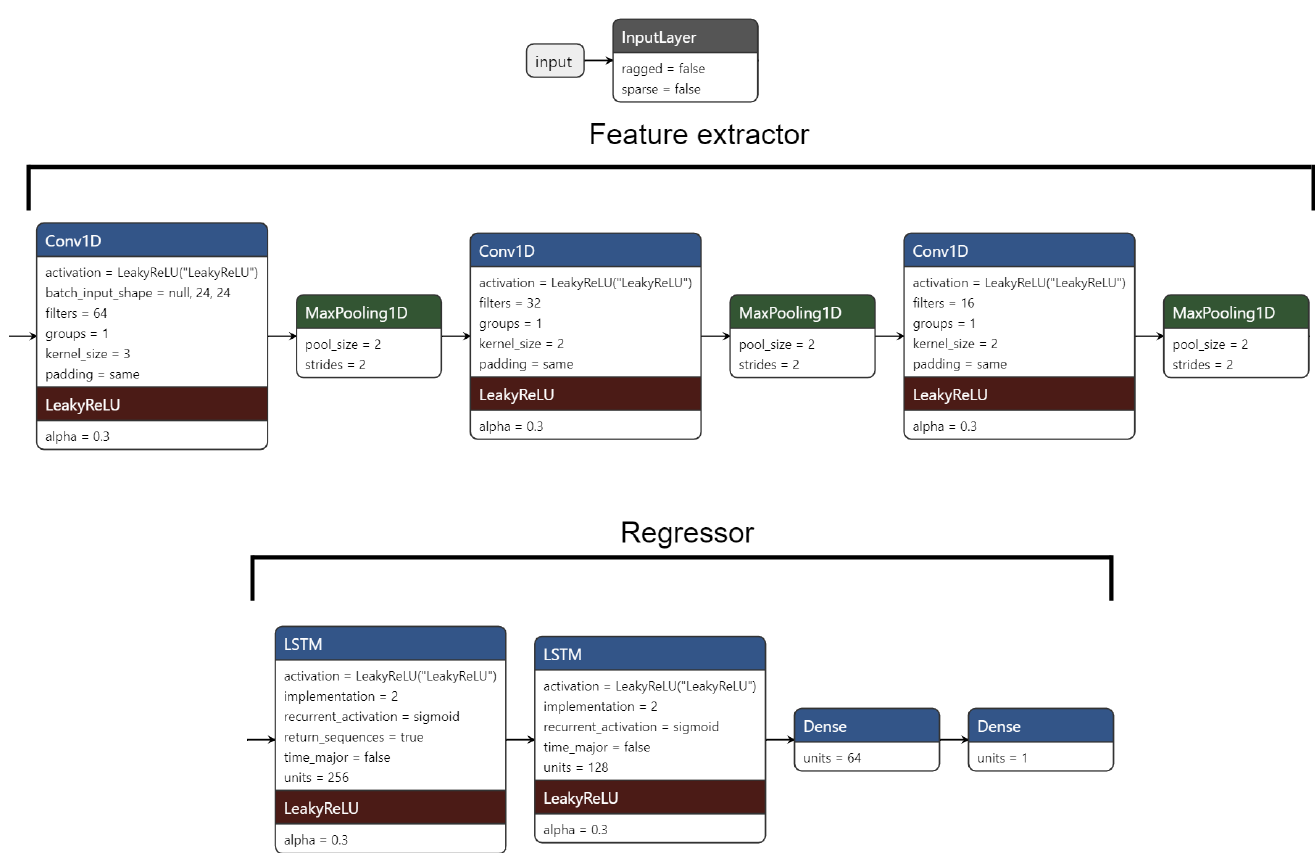
Figure 14. A simple, example CNN-LSTM network that makes one-step-ahead